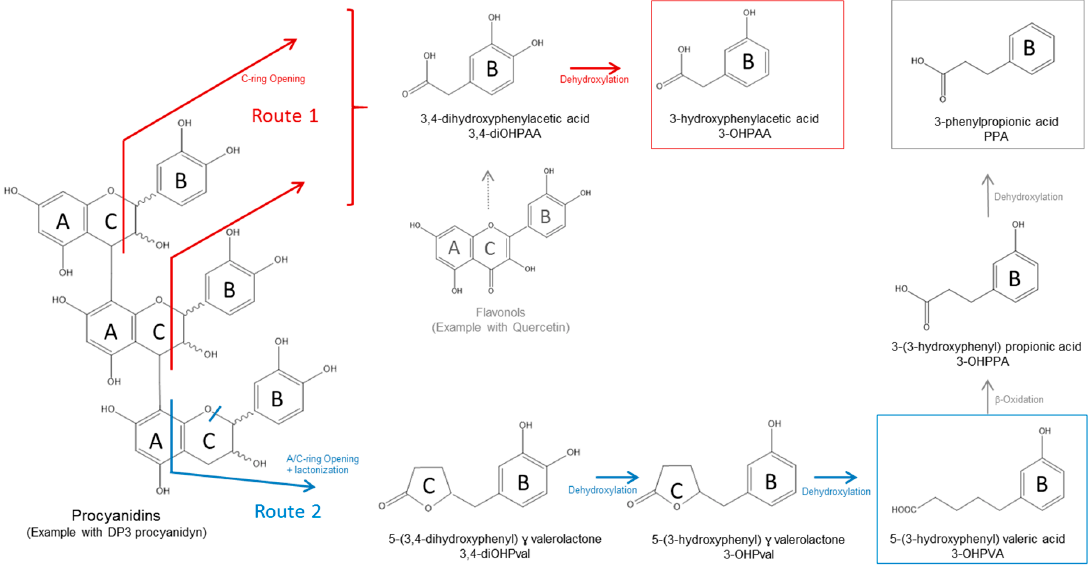
Figure 9. Proposed pathways for procyanidin catabolism by the human gut microbiota (adapted from Appeldoorn et al., 2009 [48] and Duenas et al., 2015 [53]). Route 1 in red and Route 2 in blue correspond to the hydrolysis pathways of the upper and lower units of procyanidins, respectively. The additional route in grey could have contributed to the formation of other detected metabolites. Metabolites in frames were the ones that reached a plateau after 48h fermentation (end-products). The other ones were transitory metabolites. Flavonols (<2% w / w of apple matrices) were added in the figure because they may contribute to the formation of hydroxyphenylacetic acid metabolites according to Del Rio et al. 2013